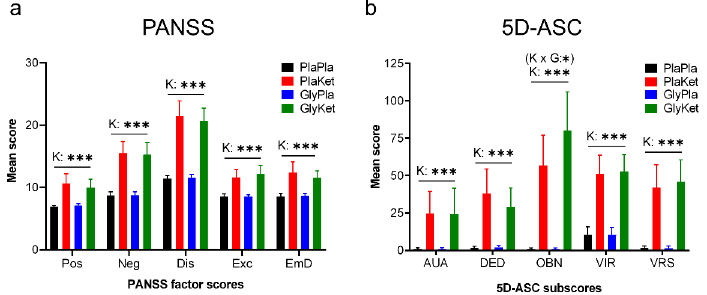
Figure 1. Bar charts of the means (+95% CI) of ( a ) the five Positive and Negative Syndrome Scale (PANSS) factor scores and ( b ) the five 5-Dimensional Altered State of Consciousness (5D-ASC) dimensional scores (K × G: ketamine × glycine interaction term; K: ketamine main effect; * p < 0.05; *** p < 0.001; effects that were no longer significant after FDR correction are shown in parentheses; Pos: positive symptoms; Neg: negative symptoms; Dis: disorganization symptoms; Exc: Excitement; EmD: emotional distress; AUA: Auditory Alteration; DED: Dread of Ego Dissolution; OBN: Oceanic Boundlessness; VIR: Vigilance Reduction; VRS: Visionary Restructuralization).